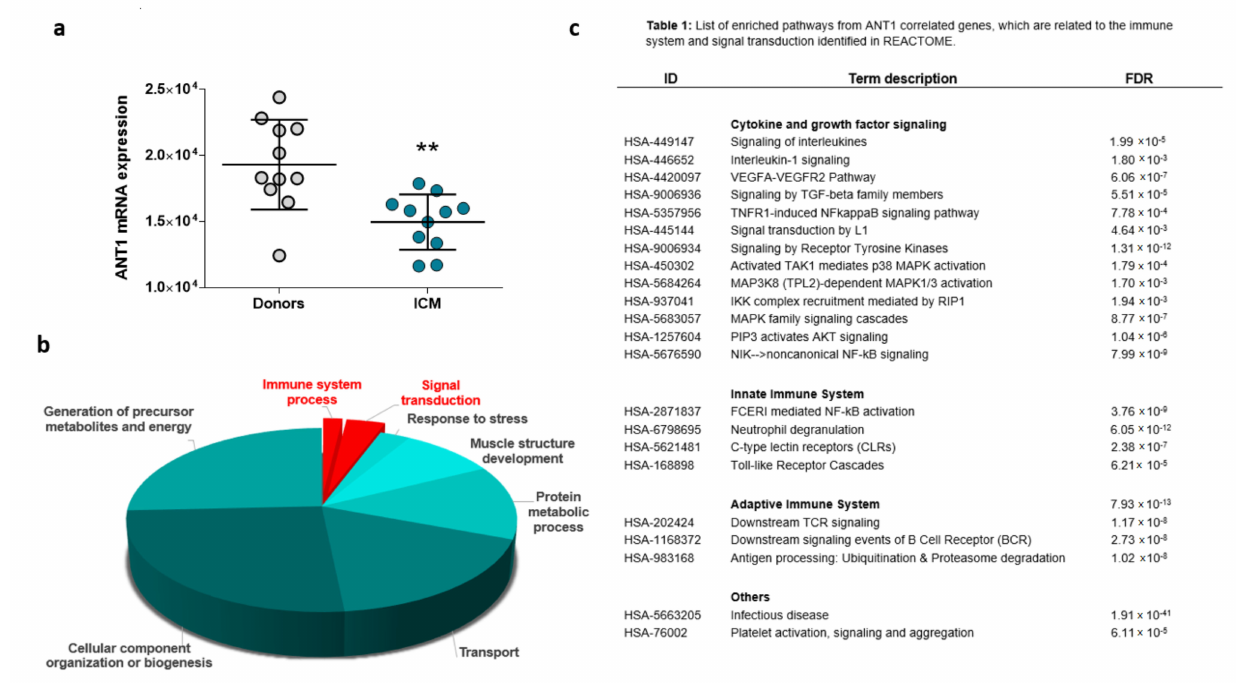
Figure 8. ANT1 correlating genes are involved in processes that regulate the immune response. Publicly available microarray data from the left ventricular heart tissue of donors and patients with ischemic cardiomyopathy (ICM) were used for Spearman’s correlation analysis to identify ANT1 (SLC25A4) co- and inverse-regulated genes. ( a ) Myocardial ANT1 transcription levels in controls and patients with ICM, ** p < 0.01. ( b ) Results of Gene Ontology (GO) enrichment analyses associated with ANT1-correlated genes; data are shown as − log ( p )-values. ( c ) List of enriched pathways from ANT1 correlated genes, which are related to the immune system and signal